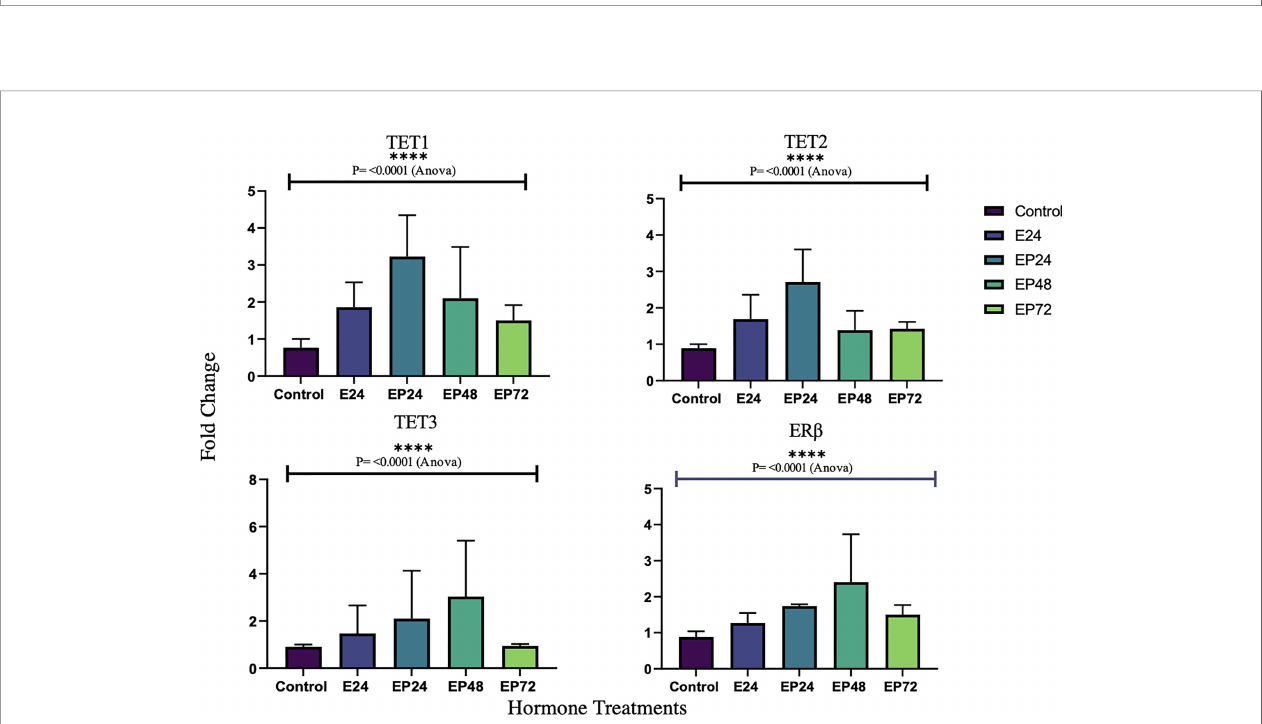
FIGURE 4 | Relative TET and ERb mRNA expression in response to different steroid hormone treatments inRL95-2 cells. The y-axisshows the foldchange of mRNA levels following different treatments comparedwith control,allresults corrected against geo-mean expressionsof three reference genes - YWHAZ, RPLOand RPL13a. The x-axis shows different treatment groupsE24 = 24h Estrogen; EP24, EP48 and EP72 = both Estrogen + Progesterone for 24, 48 and 72h.Data are presented as mean ± SEM;***P < 0.001; P ≤ 0.1 was considered as approachingsigni fi cance. One way ANOVA test revealed signi fi cant variationsin TET andERb expression across treatments (****P<0.0001). The experimental setupincluded three independentsets ofcellculture experiments (n=3) and triplicates of each sample for the RT-PCR.